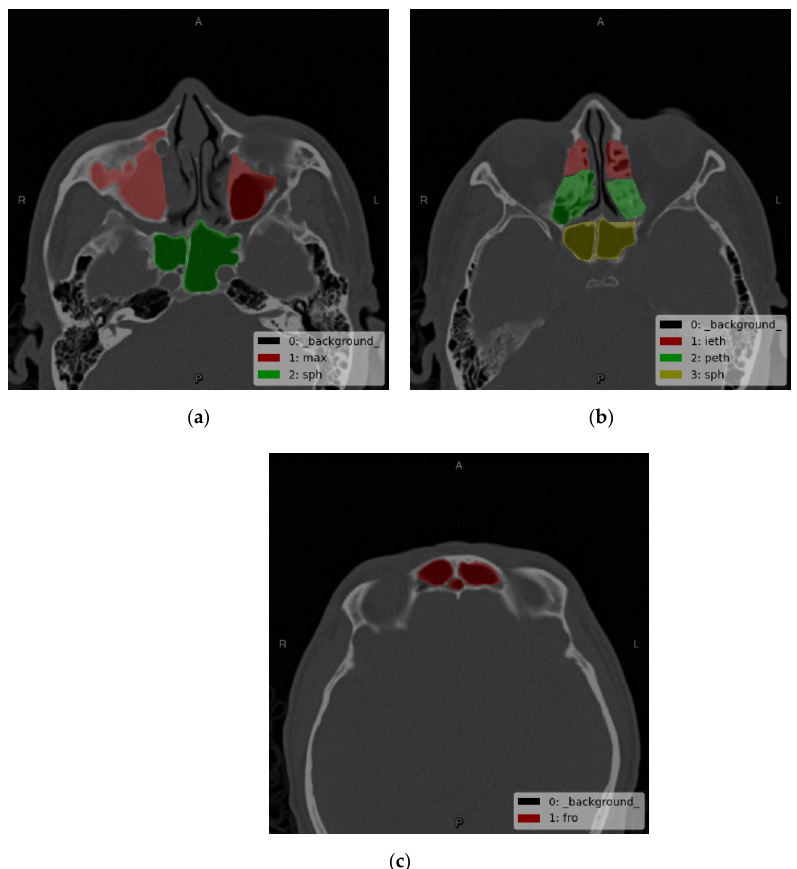
Figure 1. ( a – c ) are the schematic diagram of image labeling.